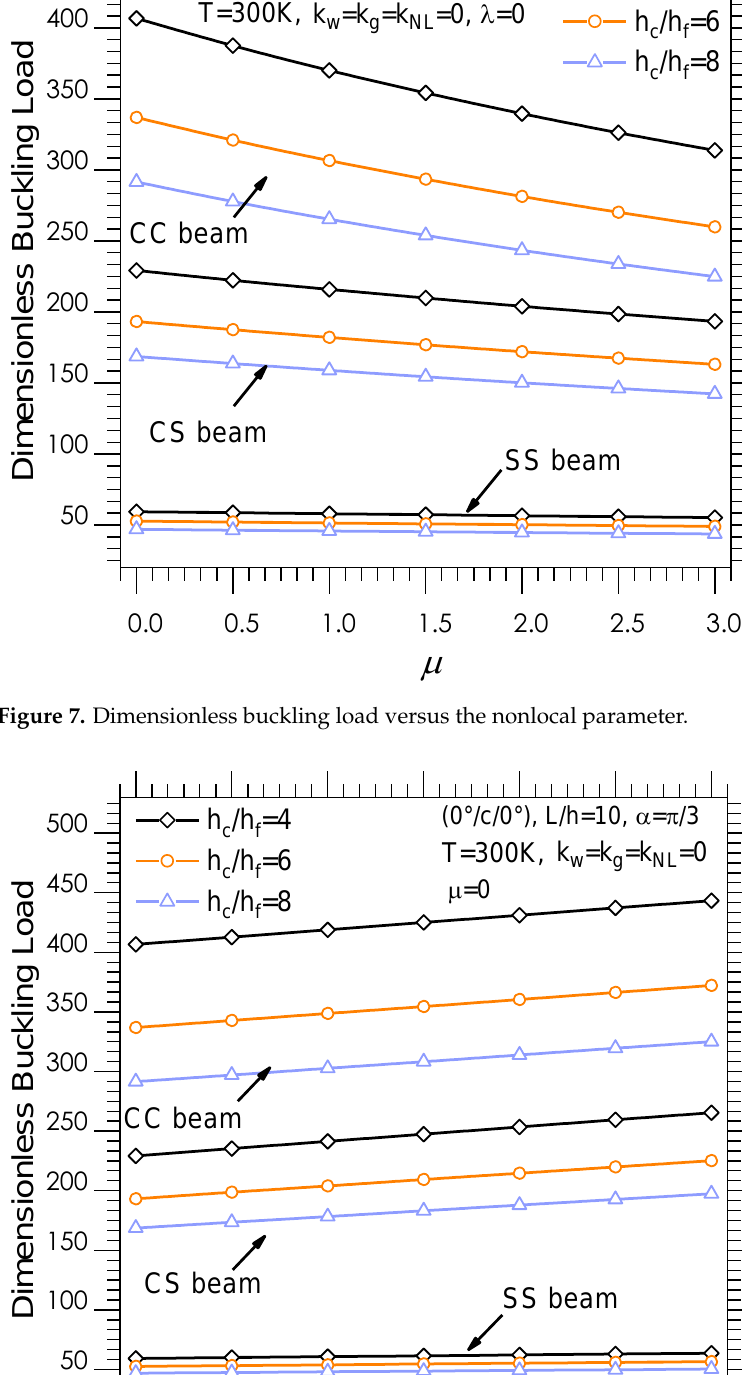
Figure 6. Dimensionless buckling load versus temperature.